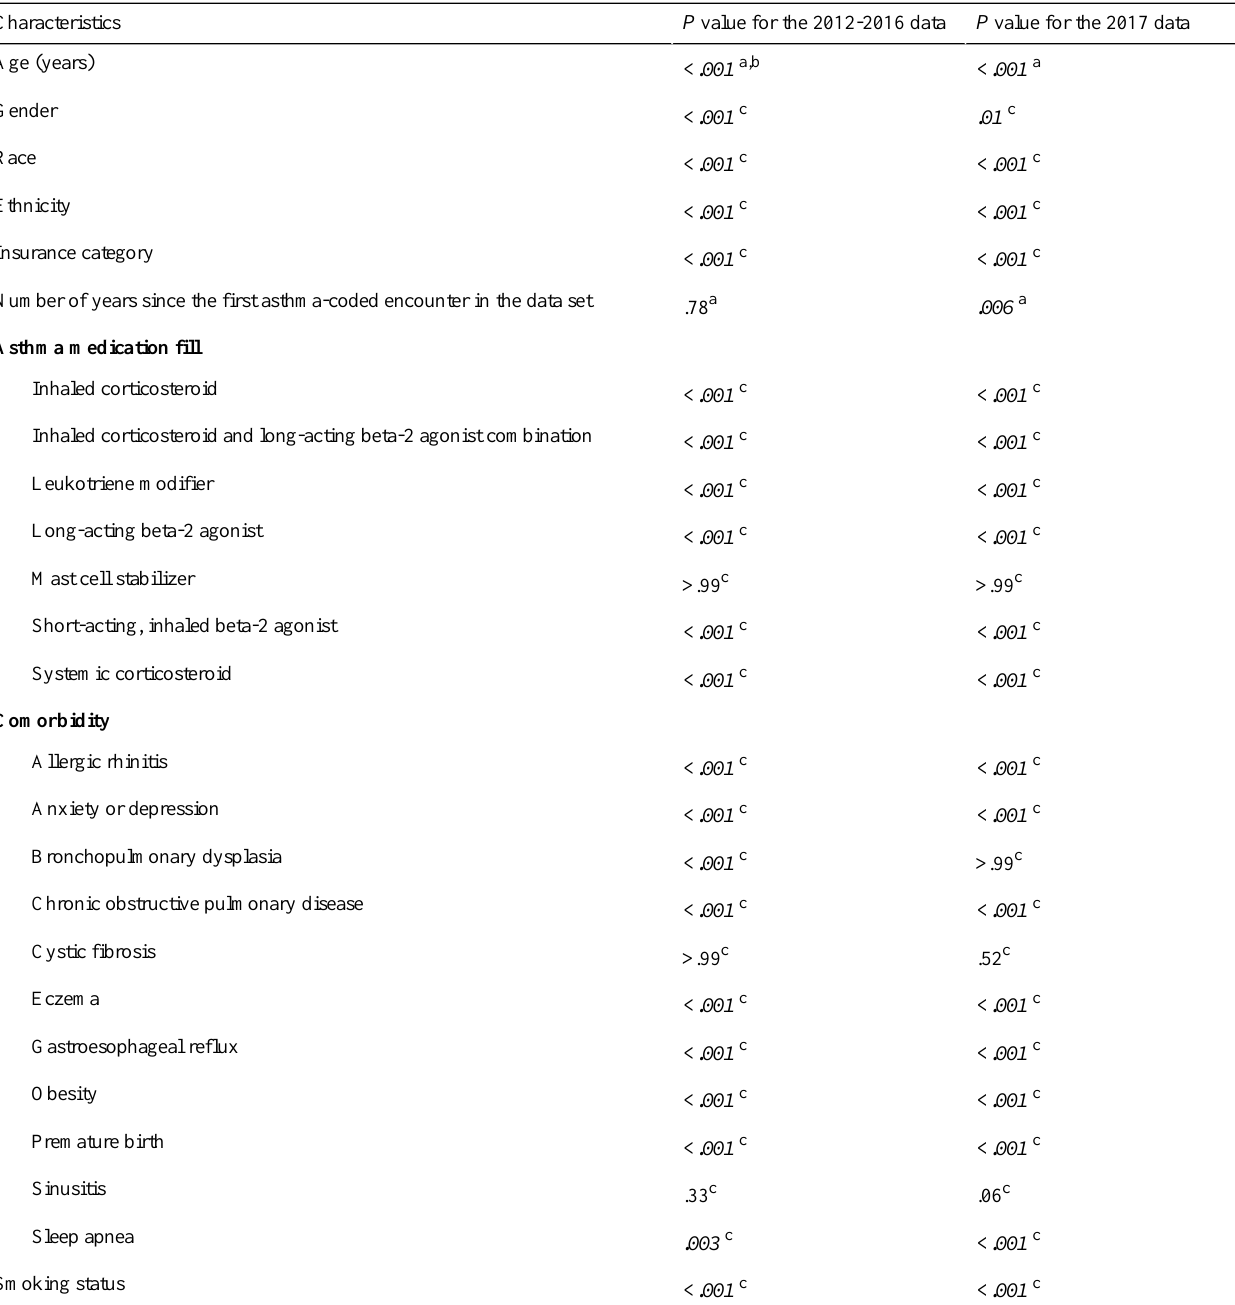
Table 2. For each clinical or demographic characteristic, the statistical test results on whether the data instances linking to future asthma-related hospital encounters and those linking to no future asthma-related hospital encounter had the same distribution.